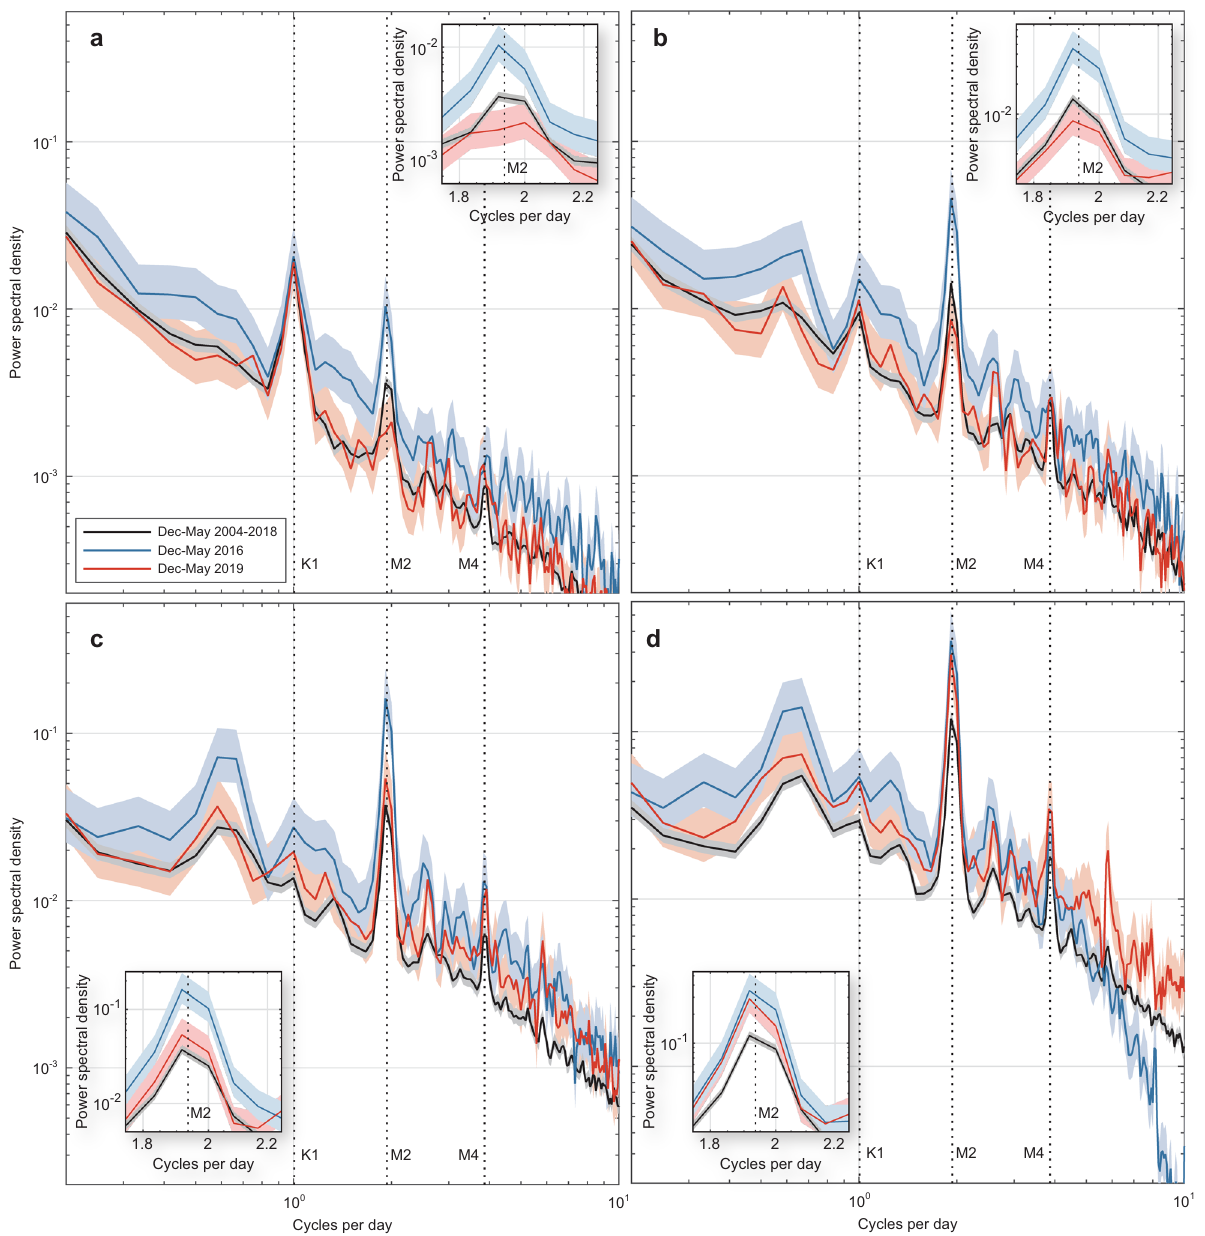
Fig. 4 | Reduced semi-diurnal temperature variability during the summer of 2019 in shallower water on the north shore of Moorea. Power spectral density (PSD) plots (logarithmic scale) were computed within a 12-day window at a 10m, b 20m, c 30m,and d 40mwaterdepthsduringthesummermonths(Dec – May)in 2016(blue),2019(red),and 2004 – 2018(black;excluding2016and2019).Shading